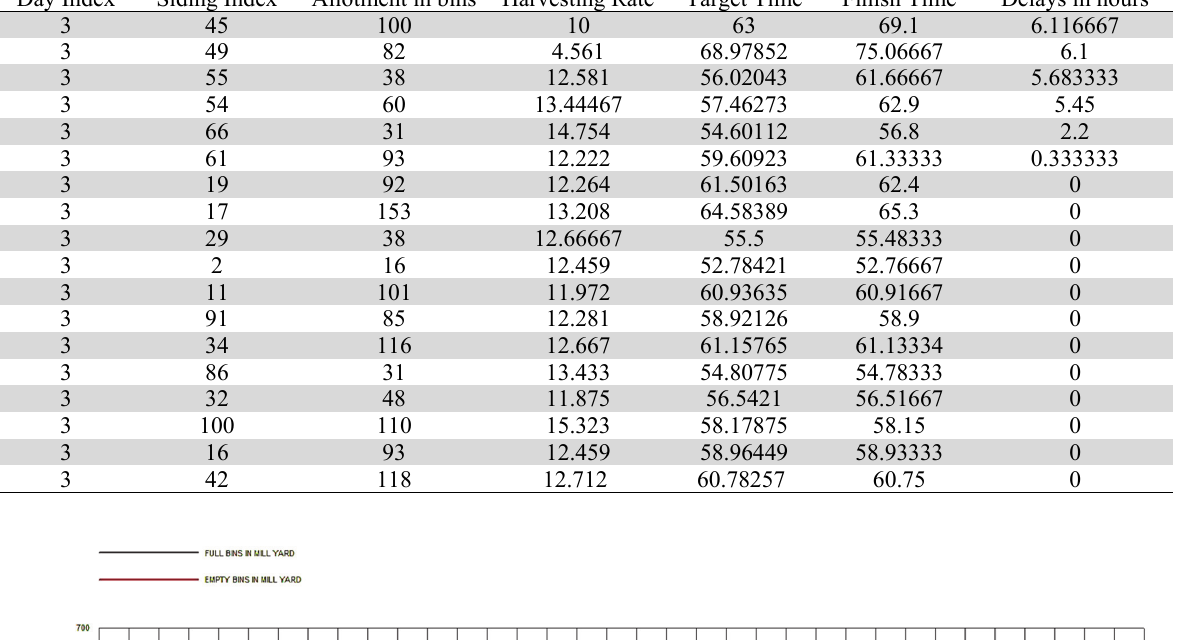
Delays of crop collections from several sidings in day 3